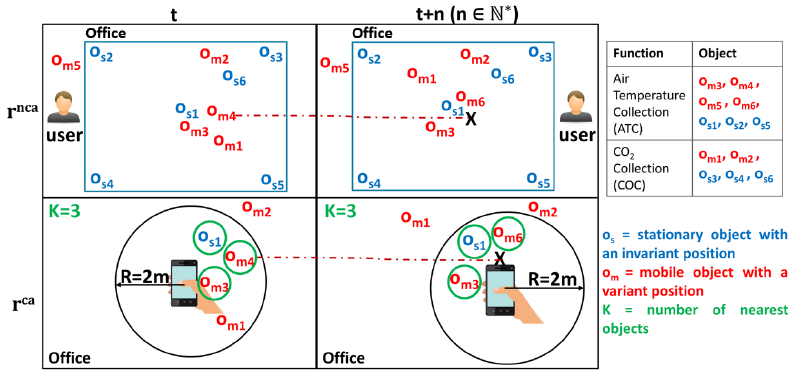
Figure 1. Examples of r nca and r ca in